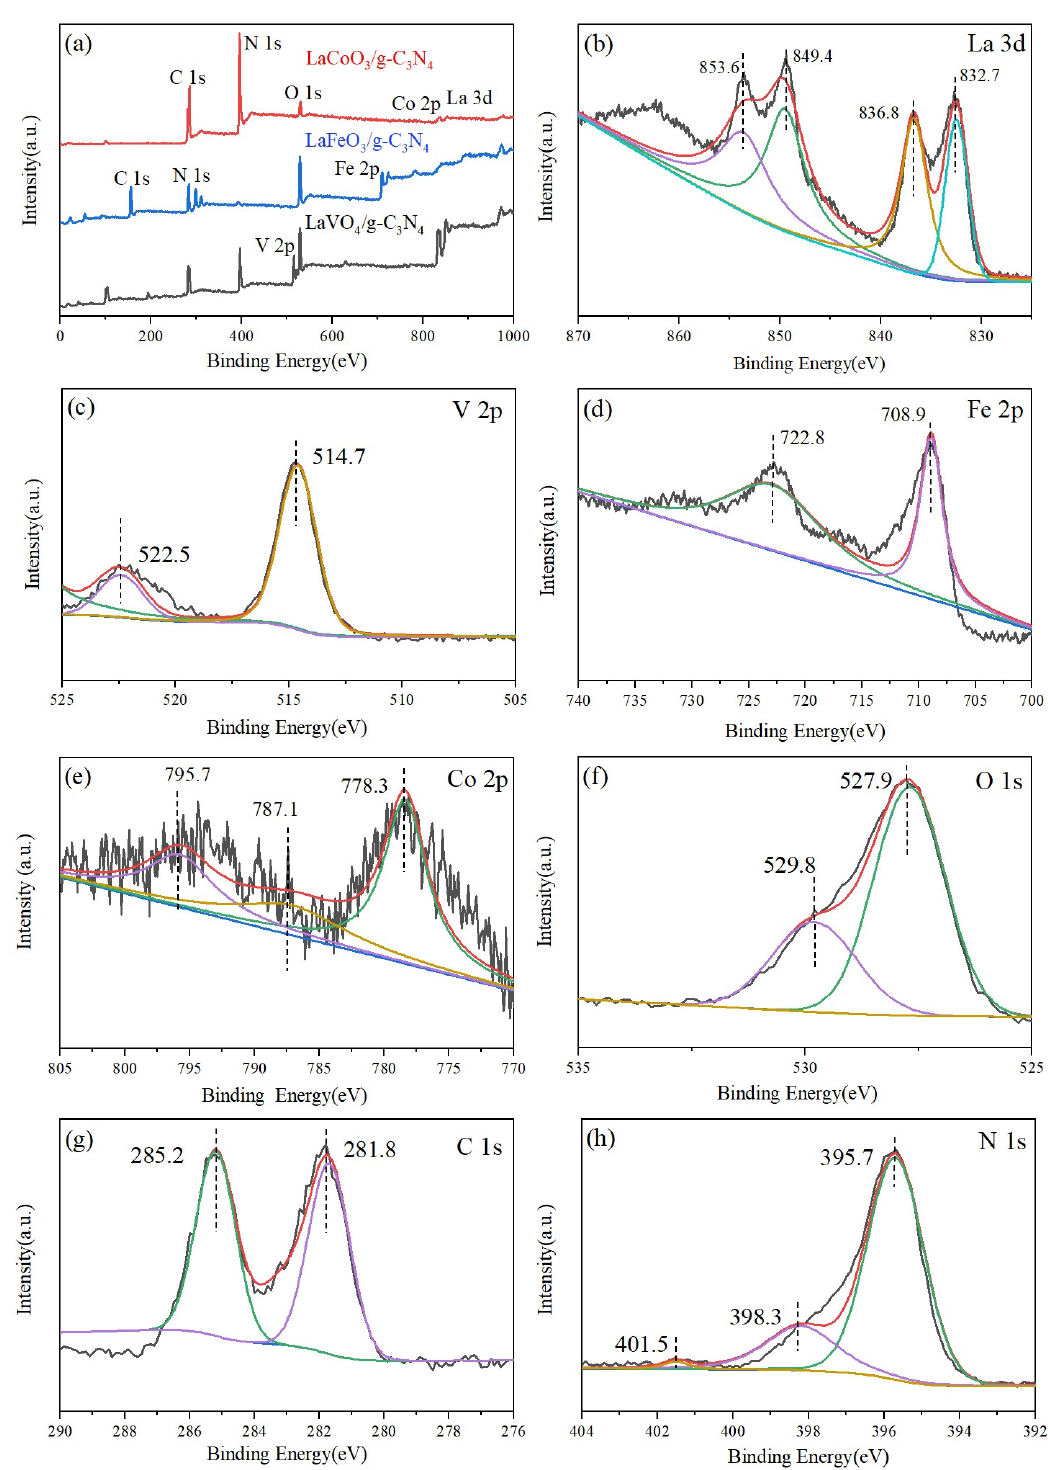
Figure 4. ( a ) XPS spectra of LaAO x /g-C 3 N 4 (A = V, Fe, Co) nanocomposites a survey of the samples, ( b ) La 3d, ( c ) V 2p, ( d ) Fe 2p, ( e ) Co 2p, ( f ) O 1s, ( g ) C 1s, and ( h ) N 1s. Figure 5 is the UV–vis diffuse reflectance spectra of g-C 3 N 4 , LaAO x , and LaAO x /g- C 3 N 4 (A = V, Fe, Co) composite photocatalyst, and it is apparent that in Figure 5a, at the wavelength range from 300 to 800 nm, pristine LaCoO 3 and LaFeO 3 revealed an intense absorption over the total visible light range. It could be seen that the absorption